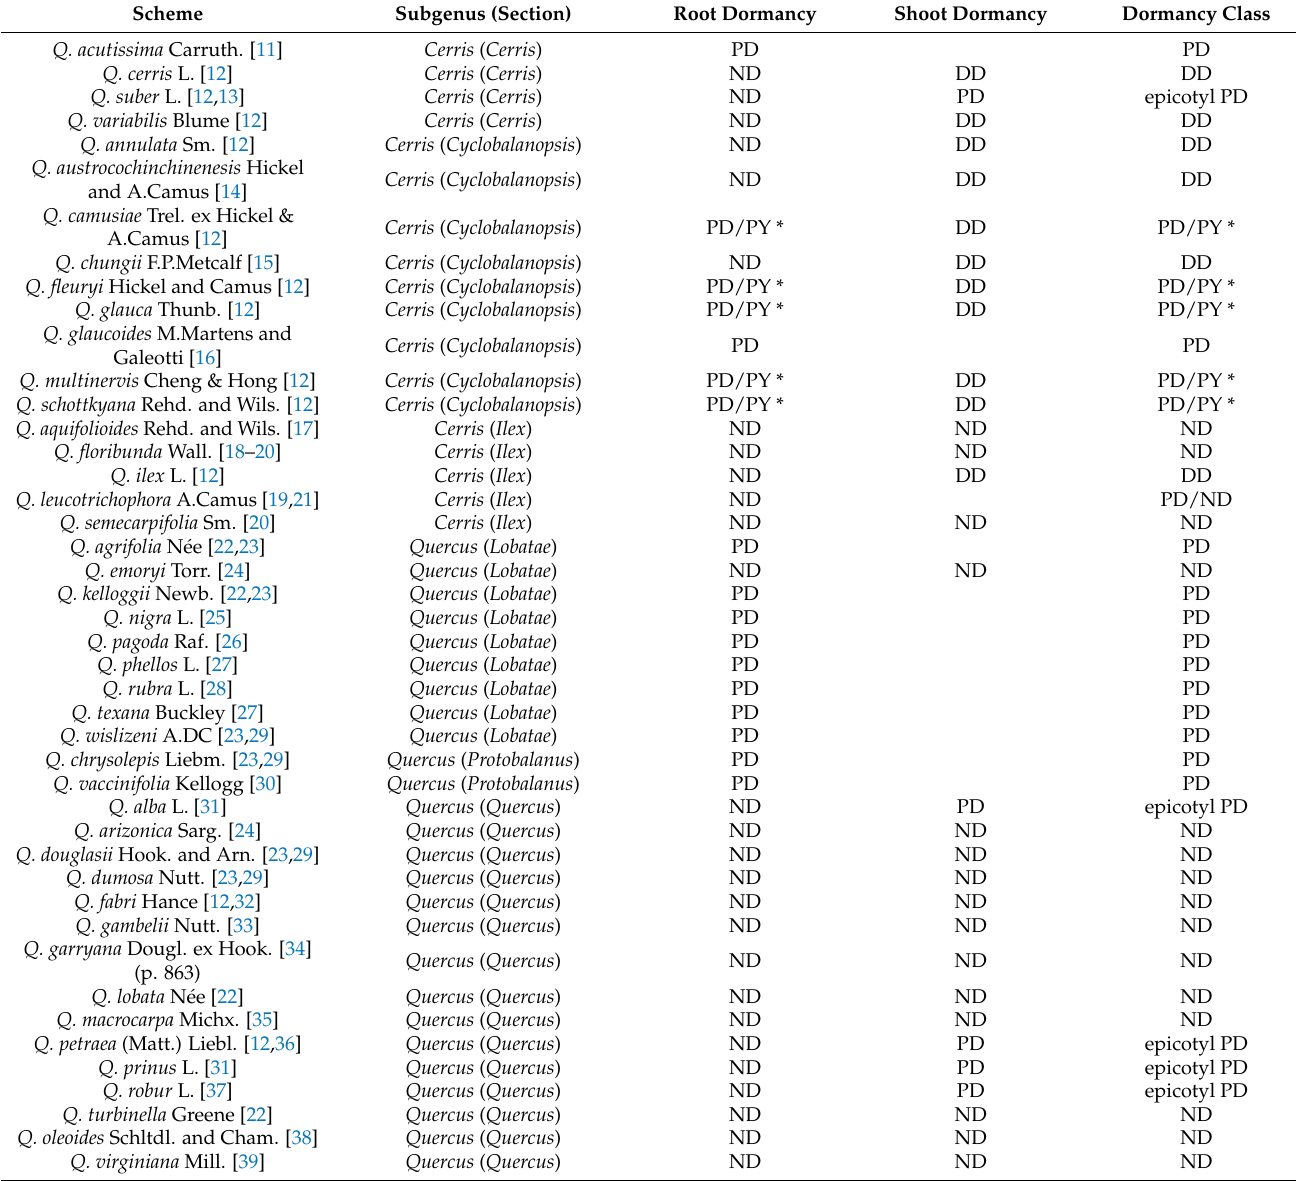
Table 1. Seed dormancy classes in different Quercus subgenera and